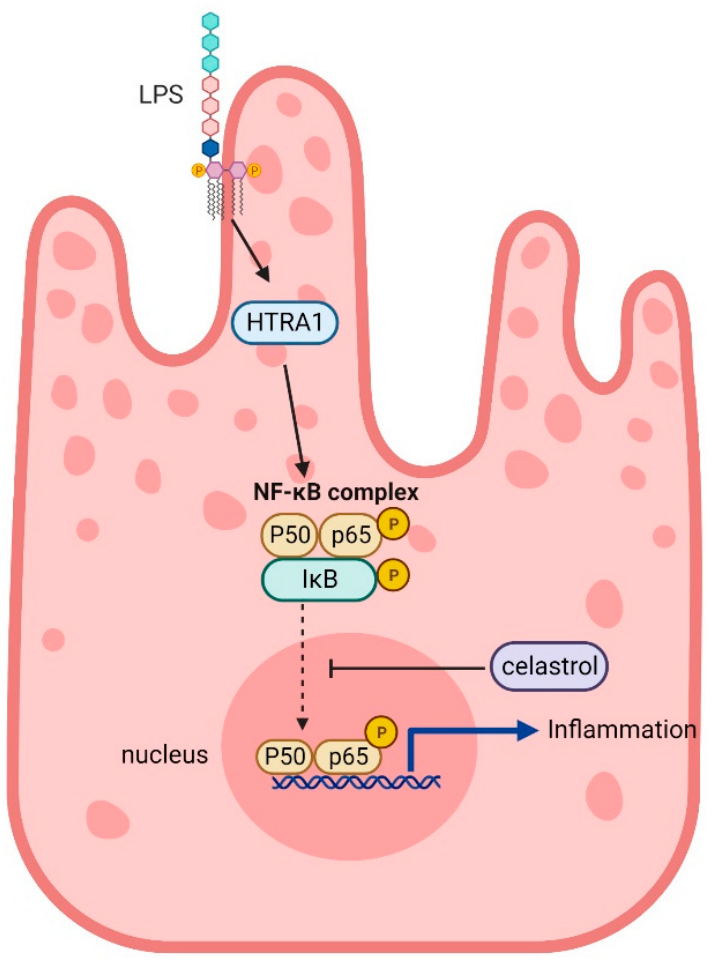
Figure 6. Schematic diagram demonstrating the role of HTRA1 in LPS-induced inflammation in RPE cells and potential therapeutic application of celastrol in AMD.